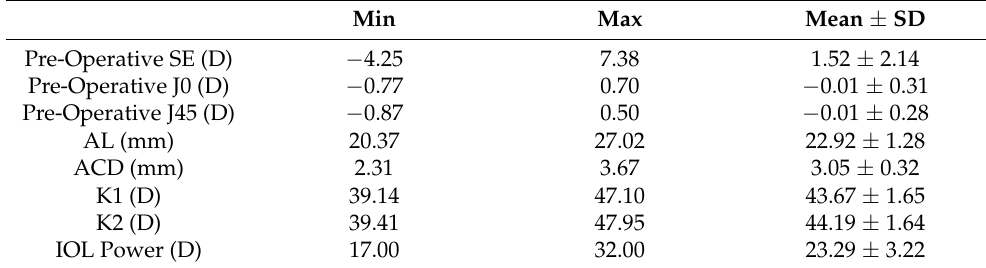
Table 1. Descriptive statistics of the